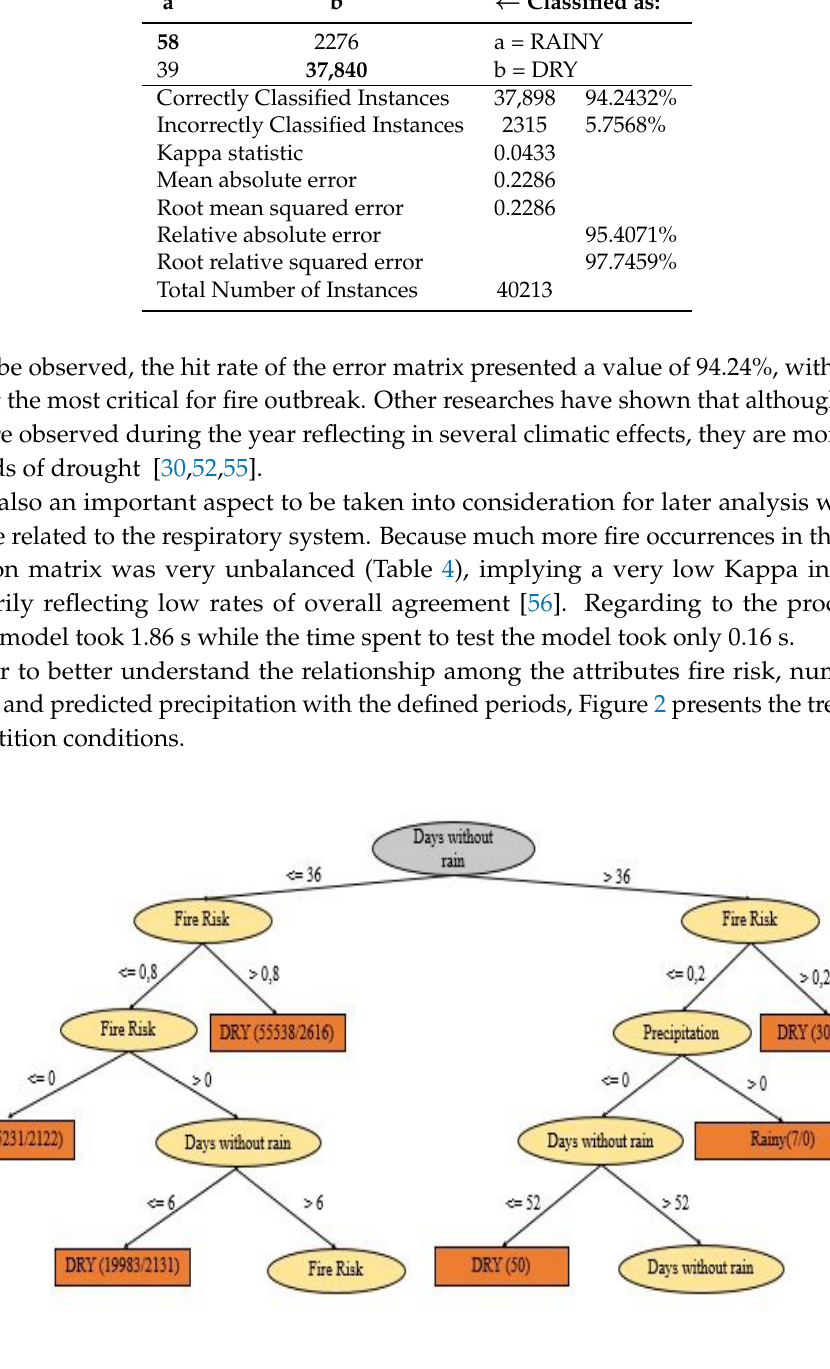
Figure 2. Representation of the